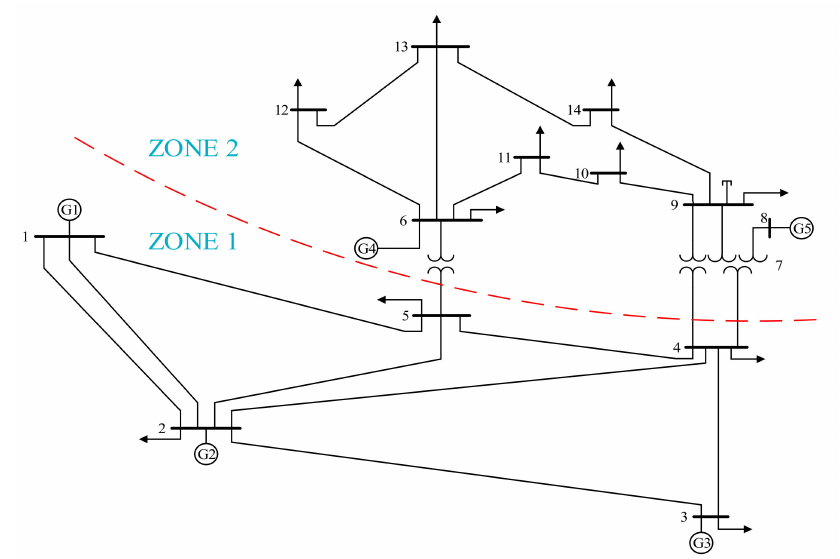
Figure 4. IEEE 14-bus standard system.